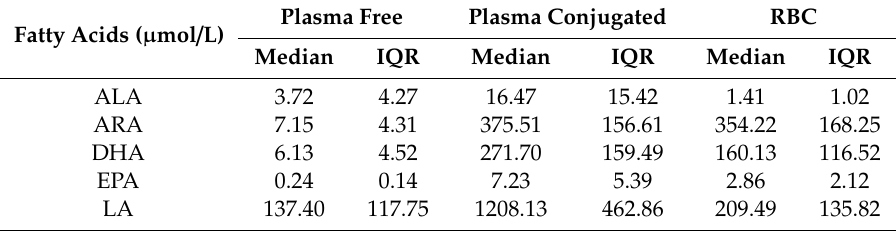
Table A1. Descriptive statistics for fatty acids in plasma and RBC membranes. Fatty Acids ( µ mol / L)